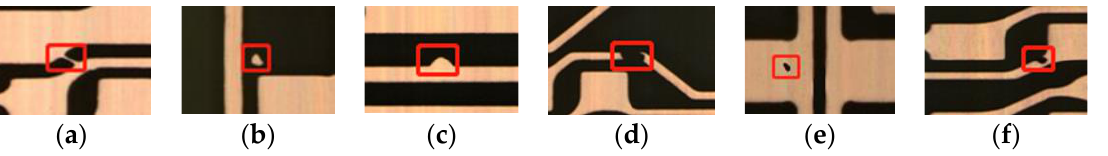
Figure 14. Defect type of circuit board. ( a ) Short. ( b ) Spurious copper. ( c ) Spur. ( d ) Open. ( e ) Pinhole. ( f ) Mouse bite.